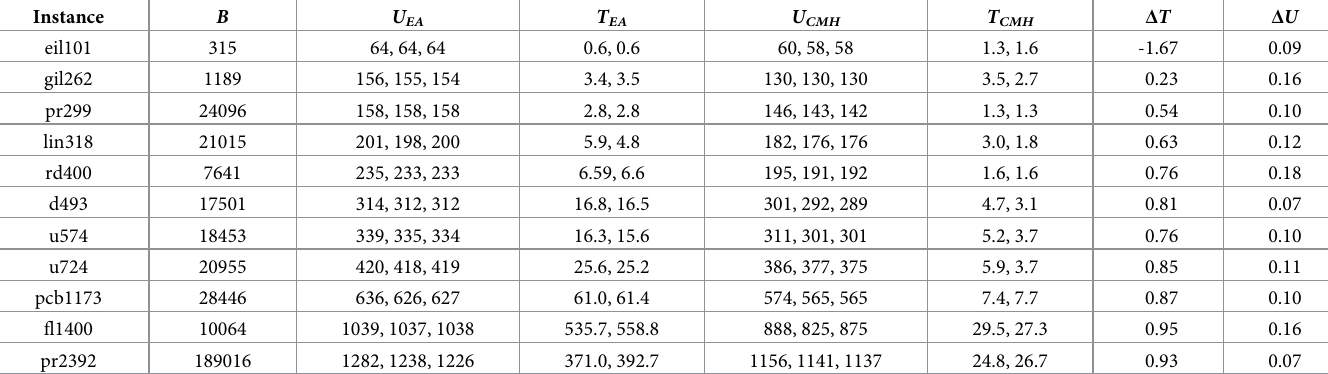
Table 1. Performance of EA4OP as standalone algorithm and when used in the clustering metaheuristic ( Flat instances). Instance